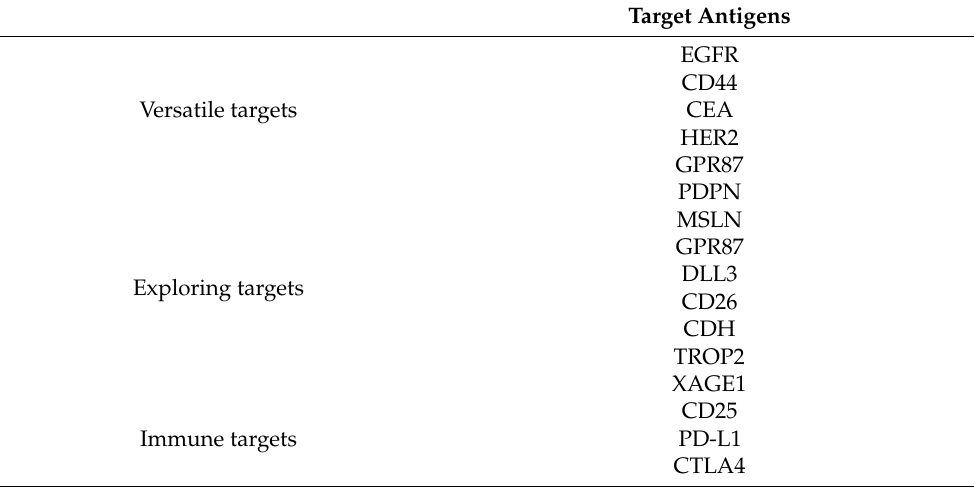
Table 1. Candidate targets for thoracic